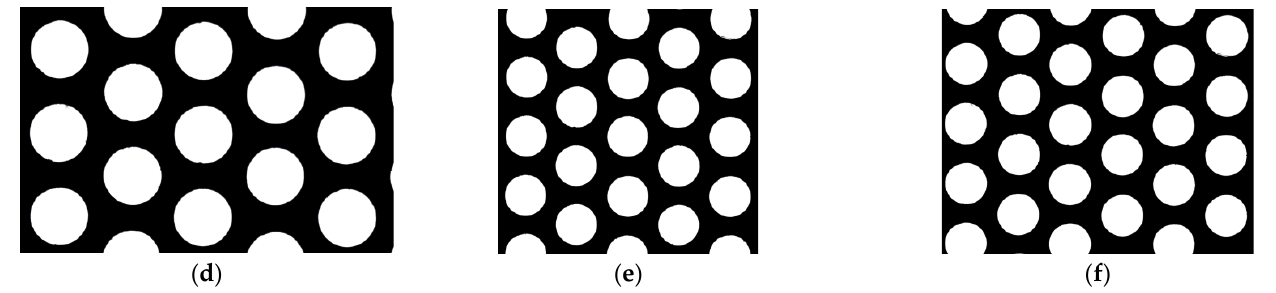
Figure 2. Experimental images of different number of punched circles. ( a ) The original image of nickel - plated punched steel strip. ( b ) The image of 6 round holes. ( c ) The image of 10 round holes. ( d ) The image of 15 round holes. ( e ) The image of 17 round holes. ( f ) The image of 21 round holes.